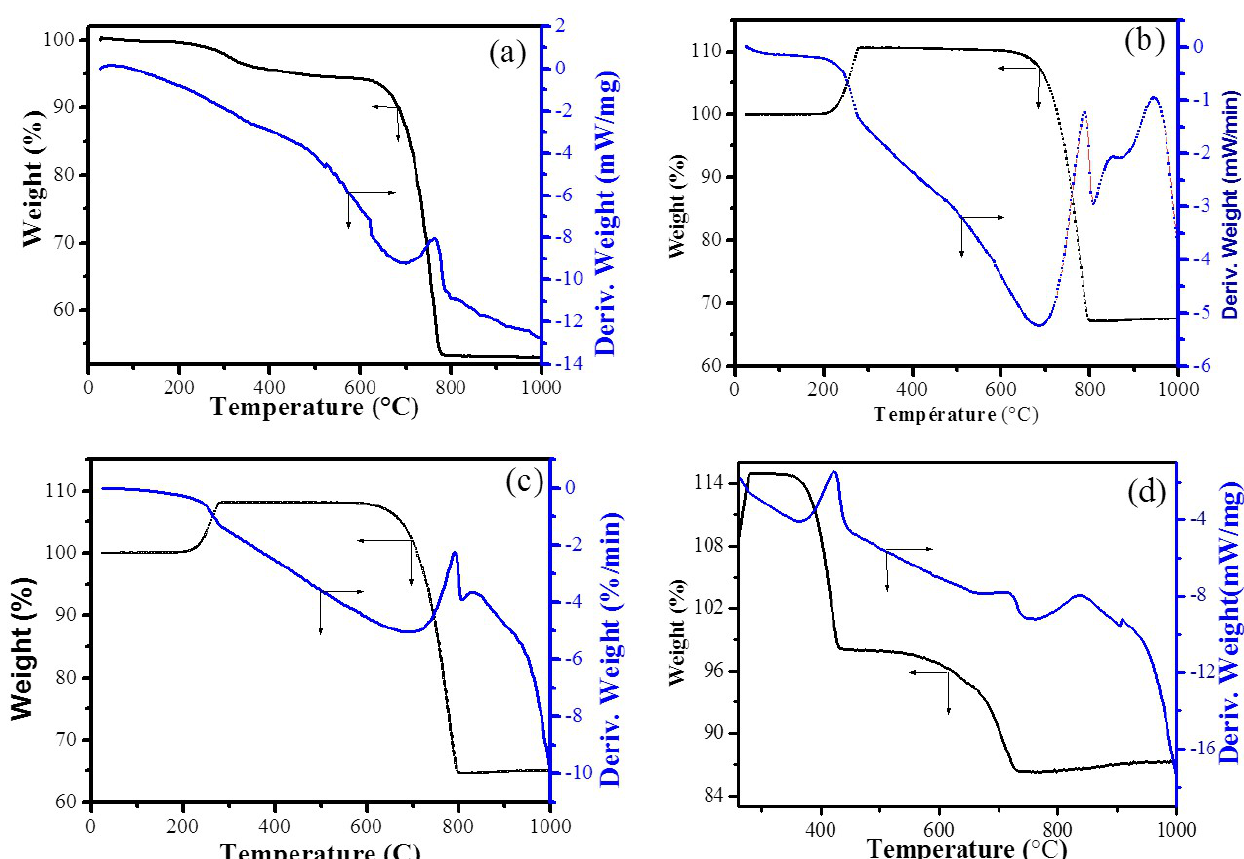
Figure 2. DTG-TG of ( a ) escN, ( b ) esc400, ( c ) esc700 and ( d ) esc1000.